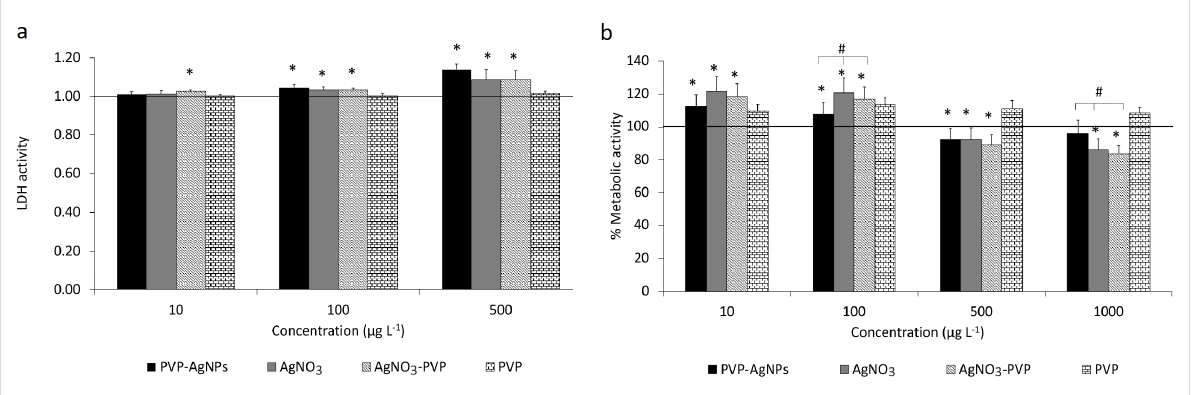
Figure 5: Effects of PVP-AgNPs, AgNO 3 , AgNO 3 -PVP, and PVP on PBMCs. PBMCs were exposed for 24 h to different concentrations of PVP- AgNPs, AgNO 3 , AgNO 3 -PVP, and PVP (0–1000 µg·L − 1 ) in RPMI. The effect on cell viability was measured using LDH leakage (a). Cell metabolic ac- tivity was assessed by MTS assay (b) and the results are expressed as percentage of reduction compared to untreated cells. Data are presented